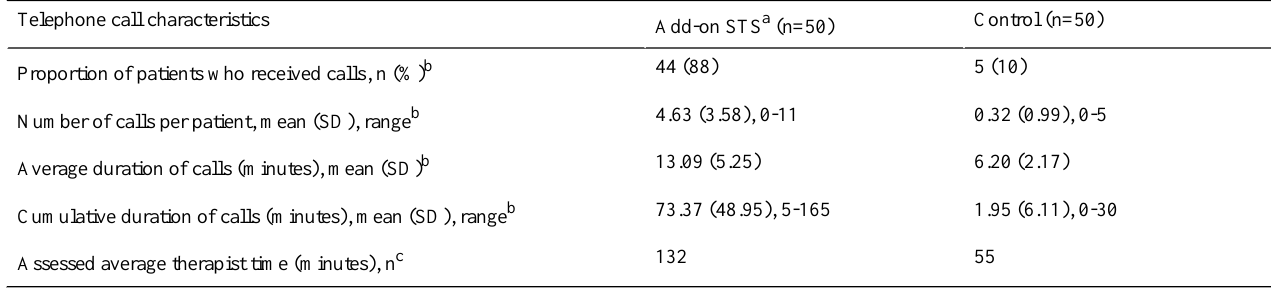
Table 2. Mean number and duration of telephone calls received.